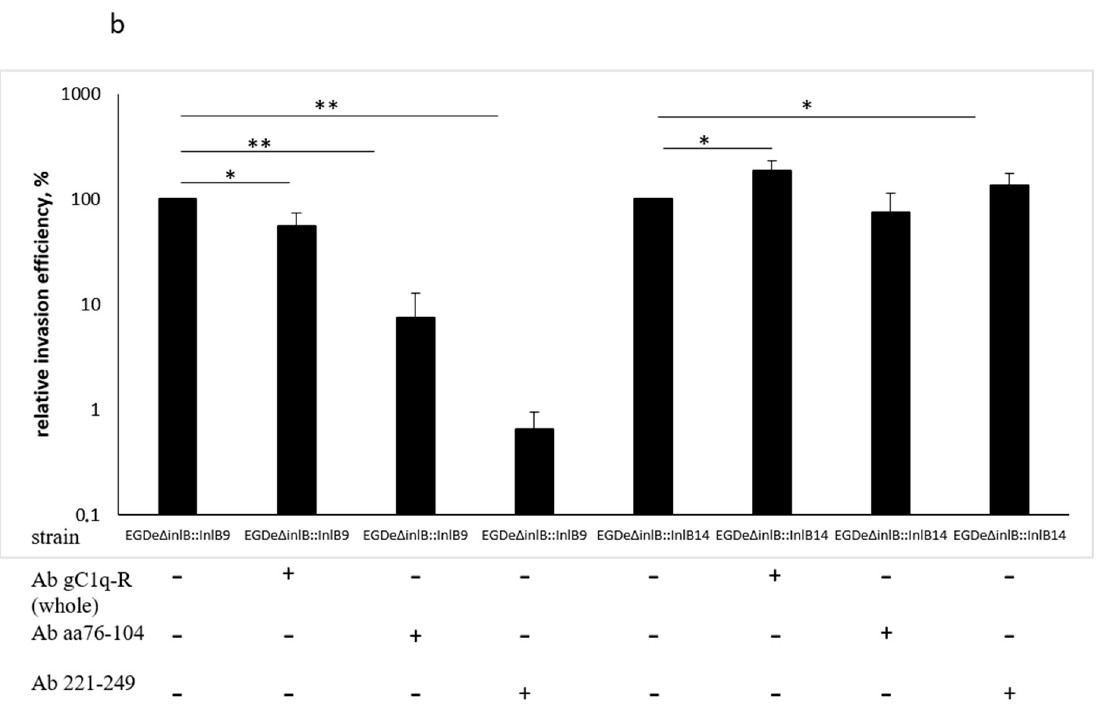
Figure 4. Invasion efficiency of idInlB9- but not idInlB14-carrying L. monocytogenes was